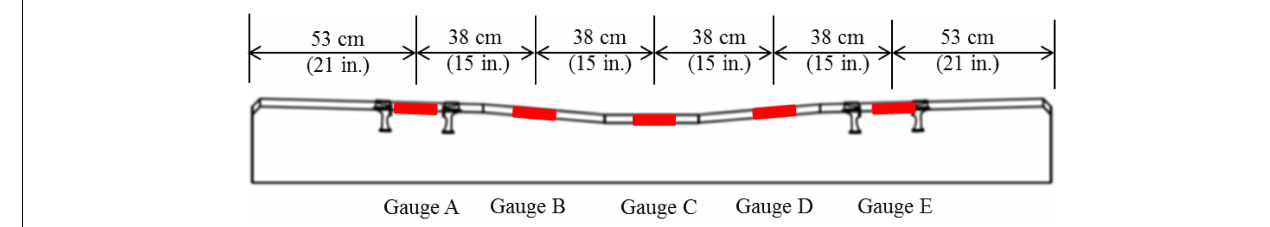
FIGURE 1 | Profile view of sleeper showing locations of strain gauges (Wolf, 2015).